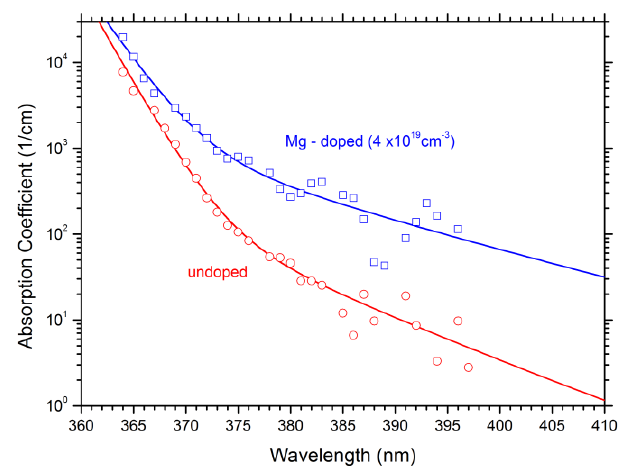
Figure 10. GaN absorption coefficients vs. photon wavelength with and without Mg doping. The GaN band gap wavelength is 363nm. Dots—measurement; lines—fitted band-tail model [108].